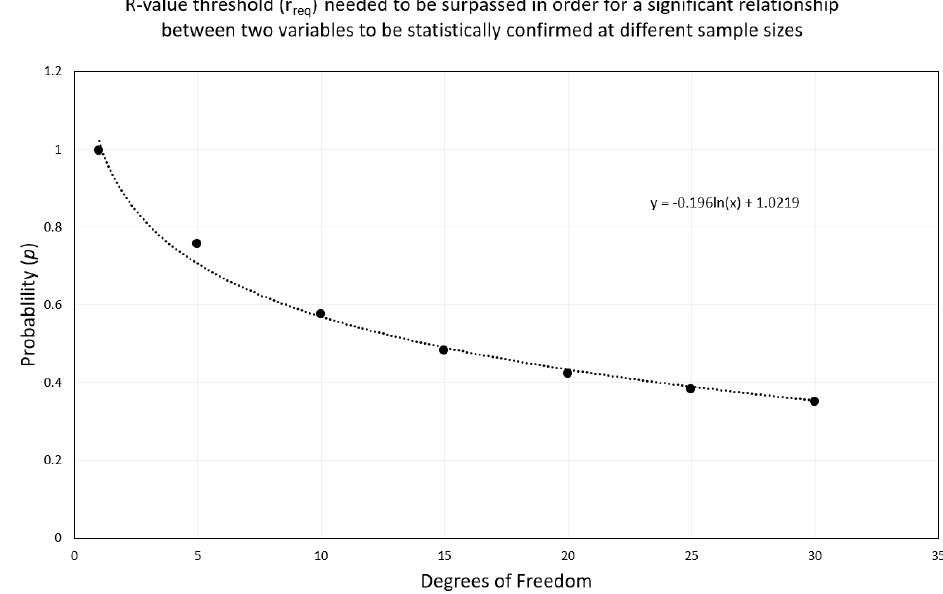
Figure 1. Graph showing r req , or p , probability needed for the correlation coefficient, r , to be equal or more than for a statistically significant correlation to be